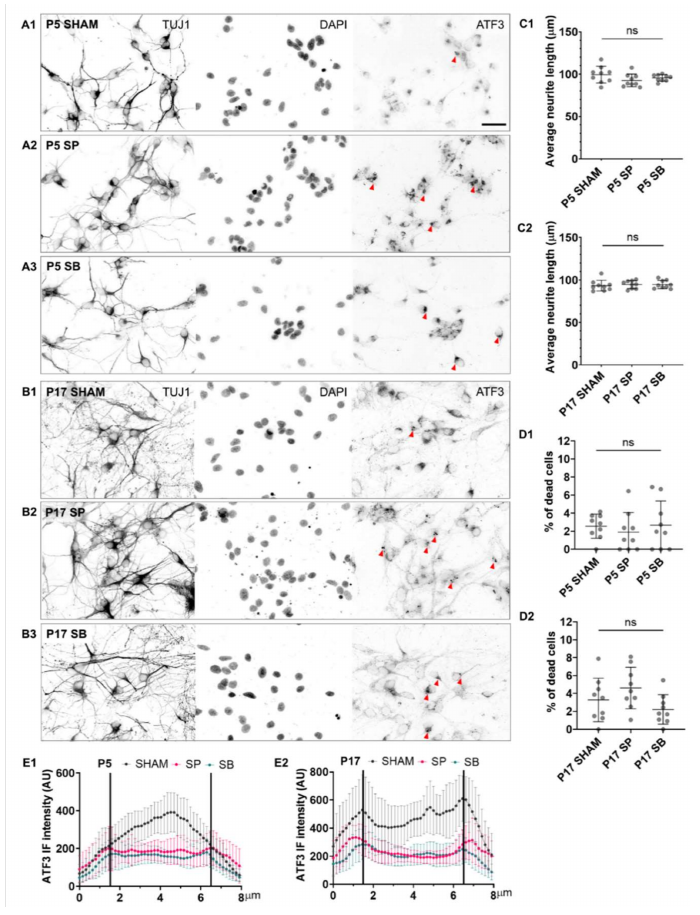
Figure 4. The effect of ATF3 inhibitors on intact neuronal networks. The primary neuronal cultures derived from the P5 ( A1 – A3 ) and P17 ( B1 – B3 ) cortex of M. domestica were treated at DIV4 with the MAPK inhibitors, JNK/c-Jun inhibitor SP600125 (SP), or the p38 inhibitor SB203580 (SB) for 24 h. The cells were fixed and stained at DIV5. Neurons were stained for β -tubulin III (TUJ1, left panel) and ATF3 (right panel). Red arrowheads indicate ATF3 cytoplasmic aggregates. Nuclei were counterstained with DAPI (middle panel). For a clearer visualization, the images are shown in the grayscale. Scale bar is 50 µ m. ( C1 ) The scatter plot shows the average neurite length of P5 cortical neurons for the experimental conditions shown from ( A1 – A3 ). Data are shown as mean ± SD. The total number of neurites analyzed P5 SHAM 184; SP 154; SB 216. One-way ANOVA followed by Holm-Š í d á k multiple comparisons test. P5 SHAM vs. P5 SP p = 0.13 ns; P5 SHAM vs. P5 SB p = 0.29 ns. ( C2 ) The scatter plot shows the average neurite length of P17 cortical neurons for the experimental conditions shown from ( B1 – B3 ). Data are shown as mean ± SD. The total number of neurites analyzed P17 SHAM 215; SP 223; SB 209. One-way ANOVA followed by Holm-Š í d á k multiple comparisons test. P17 SHAM vs. P17 SP p = 0.82 ns; P17 SHAM vs. P17 SB p = 0.82 ns. ( D1 ) The scatter plot shows the percentage of dead cells with mean ± SD. The total number of cells analyzed: P5 SHAM 675; SP 533; SB 543. One-way ANOVA followed by Holm-Š í d á k multiple comparisons test. P5 SHAM vs. P5 SP p = 0.77 ns; P5 SHAM vs. P5 SB p = 0.91 ns. ( D2 ) The scatter plot shows the percentage of dead cells with mean ± SD. Number of cells analyzed: P17 SHAM 960; SP 738; SB 840. One-way ANOVA followed by Holm-Š í d á k multiple comparisons test. P17 SHAM vs. P17 SP p = 0.36 ns; P17 SHAM vs. P17 SB p = 0.36 ns. For each condition, images of at least three random fields per sample from 3 culture preparations were analyzed. ( E1 ) Line scan analysis of P5 primary neurons for conditions shown from ( A1 – A3 ) and ( E2 ) P17 primary neurons for conditions shown from ( B1 – B3 ). Data are shown as an average ± SD. The graph represents the average ATF3 immunofluorescence intensity measured in 10–16 randomly selected neurons for each condition (nucleus is within the vertical lines on the